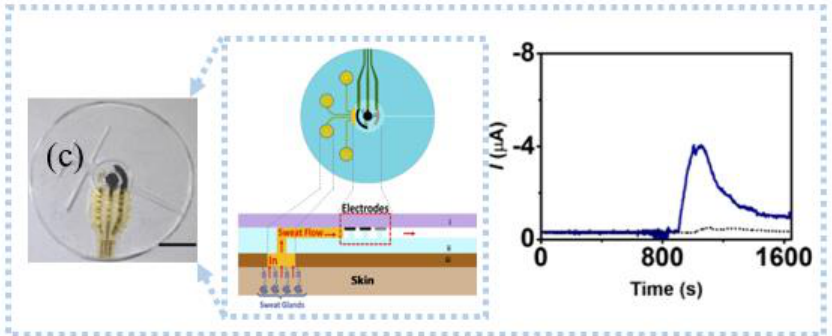
Figure 8. Sweat detection: ( a ) an electrochemical electronic tattoo applied to detect deltoid and real−time response and corresponding lactate concentrations during a cycling exercise. Reprinted with permission from Ref. [104]. Copyright 2013 American Chemical Society, ( b ) photo of paper colorimetric sensor and the sweat patch being used on the upper arm of a person working out. Reprinted with permission from Ref. [113]. Copyright 2019 Springer Nature, ( c ) Schematic repre- sentation of microfluidic device sweat collection and operation (left), physical integrity analysis of microfluidic platform (middle), and continuous lactate monitoring (right). Reprinted with permission from Ref. [117]. Copyright 2017 American Chemical